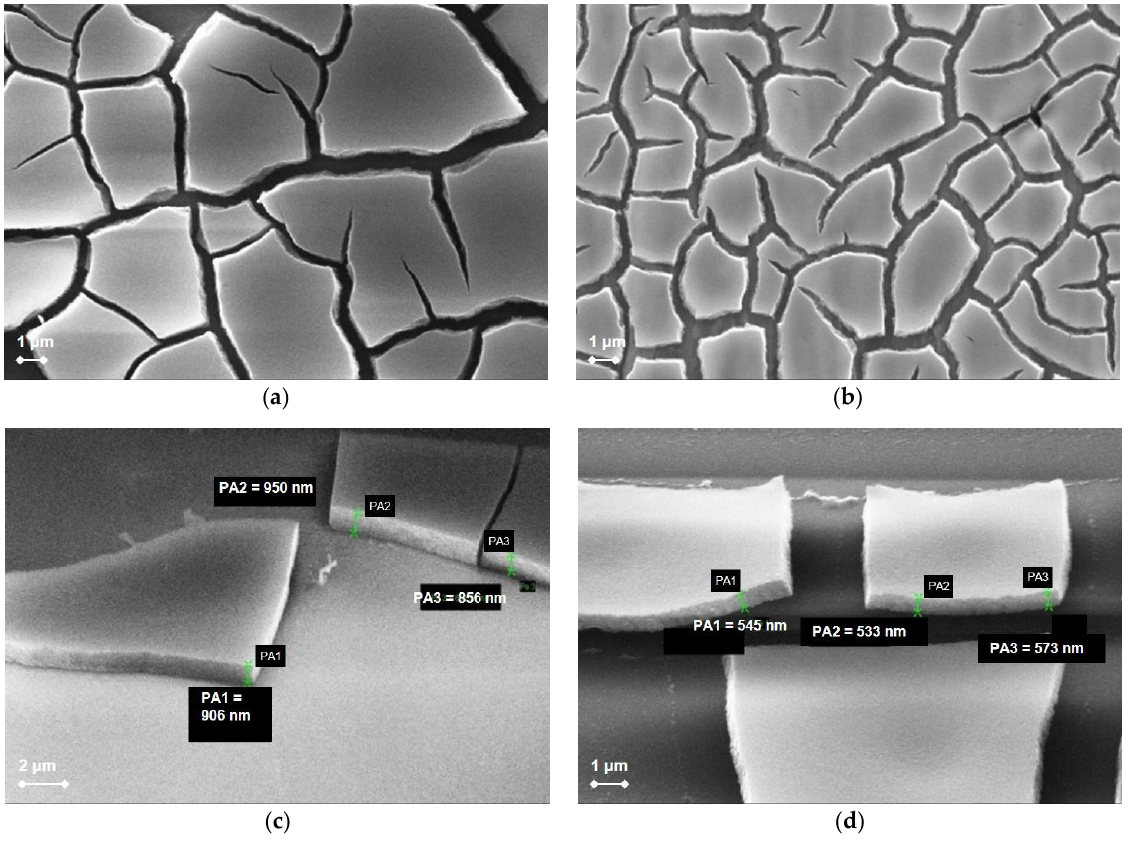
Figure 1. SEM analyses of the TiO 2 coating on glass samples. ( a ) As deposited. ( b ) After annealing at 500 °C for 2 h. ( c ) Thickness of as-deposited coating. ( d ) Thickness of coating after annealing at 500 °C for 2 h.